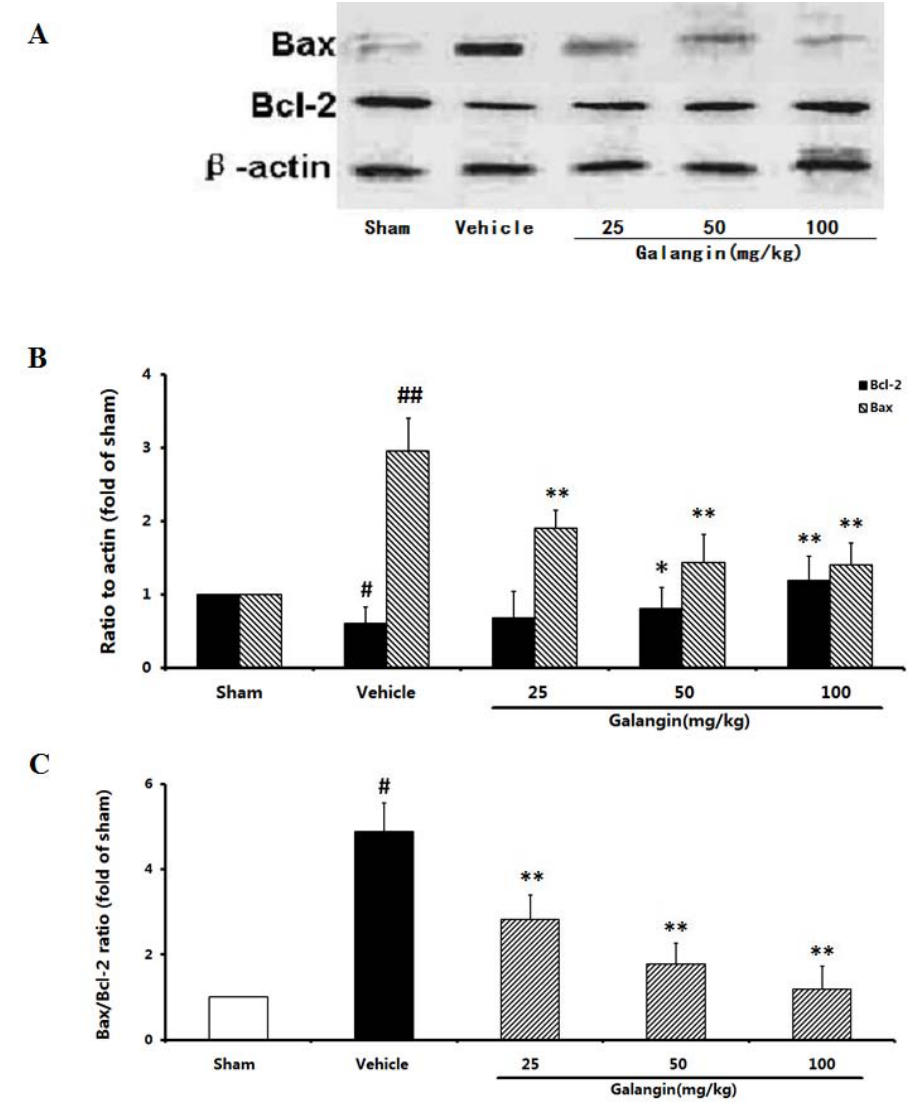
Figure 9. Effects of galangin on Bcl-2 and Bax expression in rat brain 24 h after MCAO. Galangin was administered by i.g. 15 min prior to MCAO. ( A ) Representative Western blots of Bcl-2, Bax and β -actin; ( B ) The quantified densitometric analysis of Bcl-2 and Bax levels; ( C ) The ratio of Bax/Bcl-2 proteins. The values were expressed as the mean±SD for four independent experiments, and the data were analyzed by one-way ANOVA. ## p <